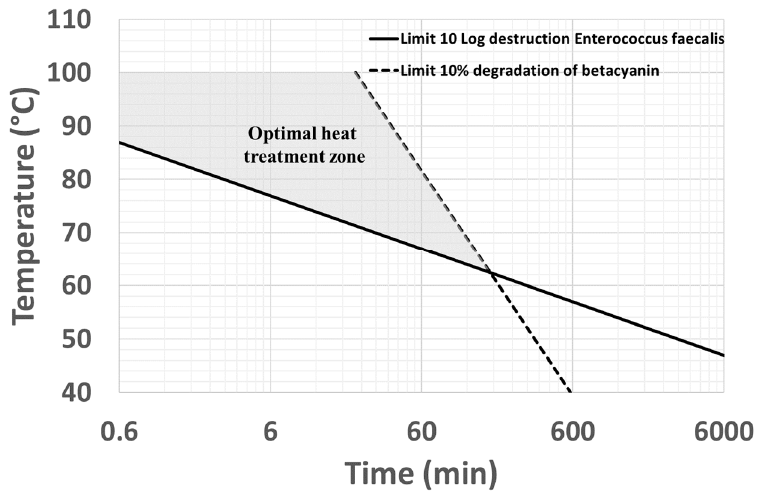
Figure 3. Representation of the evolution of the temperature of pasteurization as a function of pasteurization time. The grey zone represents the time/temperature combination that ensures both a maximum 10% reduction and a minimum 10 log reduction for Enterococcus faecalis.